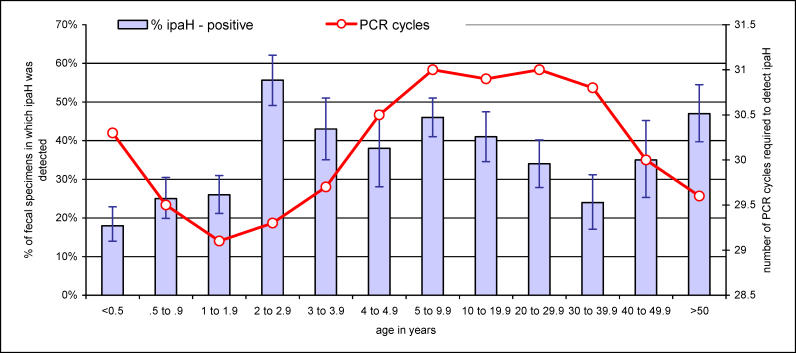
Relation of Proportion of ipaH-Positive Faecal Specimens and PCR Cycle Number to AgeThe percentage of Shigella culture-negative stool specimens from diarrhea patients in which ipaH was detected and the mean PCR cycle number required to detect ipaH by patient age suggests that children between ages 2 and 4 y and adults over age 40 y with diarrhoea are most likely to have ipaH in their stool specimens and the bacterial load is likely to be highest in these two age groups.